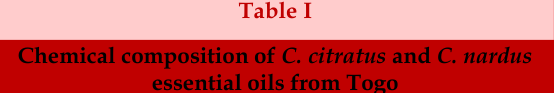
Chemical composition of C. citratus and C.